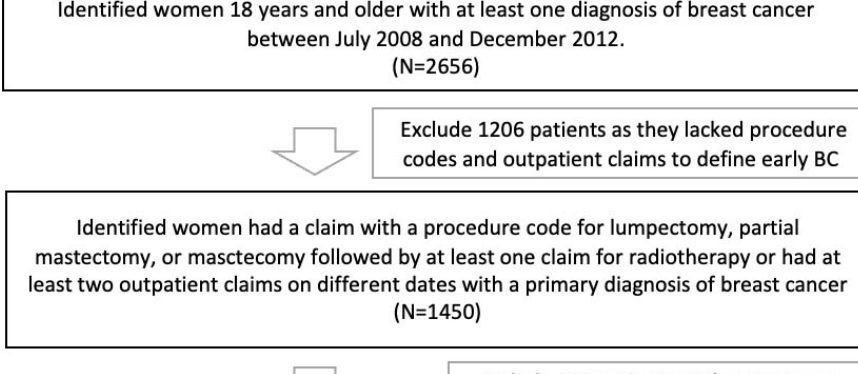
therapy. Figure 1 addresses the steps of the study ’s inclusion and exclusion criteria.